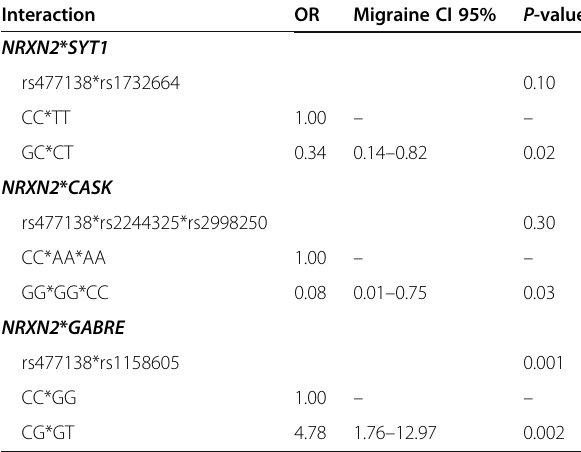
Table 3 Interaction results found between NRXN2*SYT1; NRXN2*CASK and NRXN2*GABRE, assessed by a logistic regression